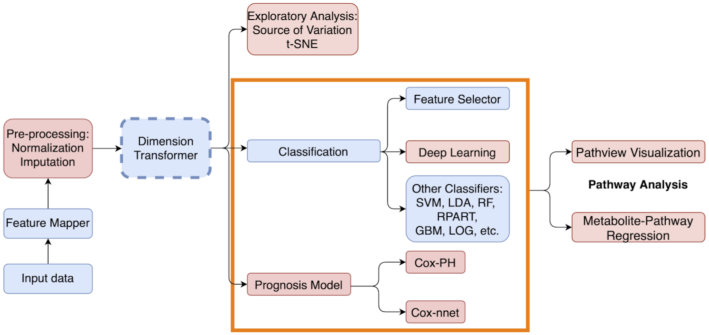
The workflow of the Lilikoi v2.0 package. Lilikoi v2.0 is composed of 7 modules: feature mapper, preprocessing, dimension transformer, exploratory analysis, classification, prognosis model, and pathway analysis. Input data require metabolomics data matrix, and 1 column of a categorical variable to specify case/control status for each subject (for classification), or survival information (for prognosis analysis). Feature mapping converts metabolite names to standardized metabolic IDs (e.g., Human Metabolome Database IDs) and then transforms them into pathway names. Preprocessing enables 3 normalization methods (standard, quantile, and median-fold) and 1 knn imputation method. The red boxes are new functionalities added to Lilikoi v2.0. Blue boxes are pre-existing modules in Lilikoi v1. Dashed box indicates an optional step.